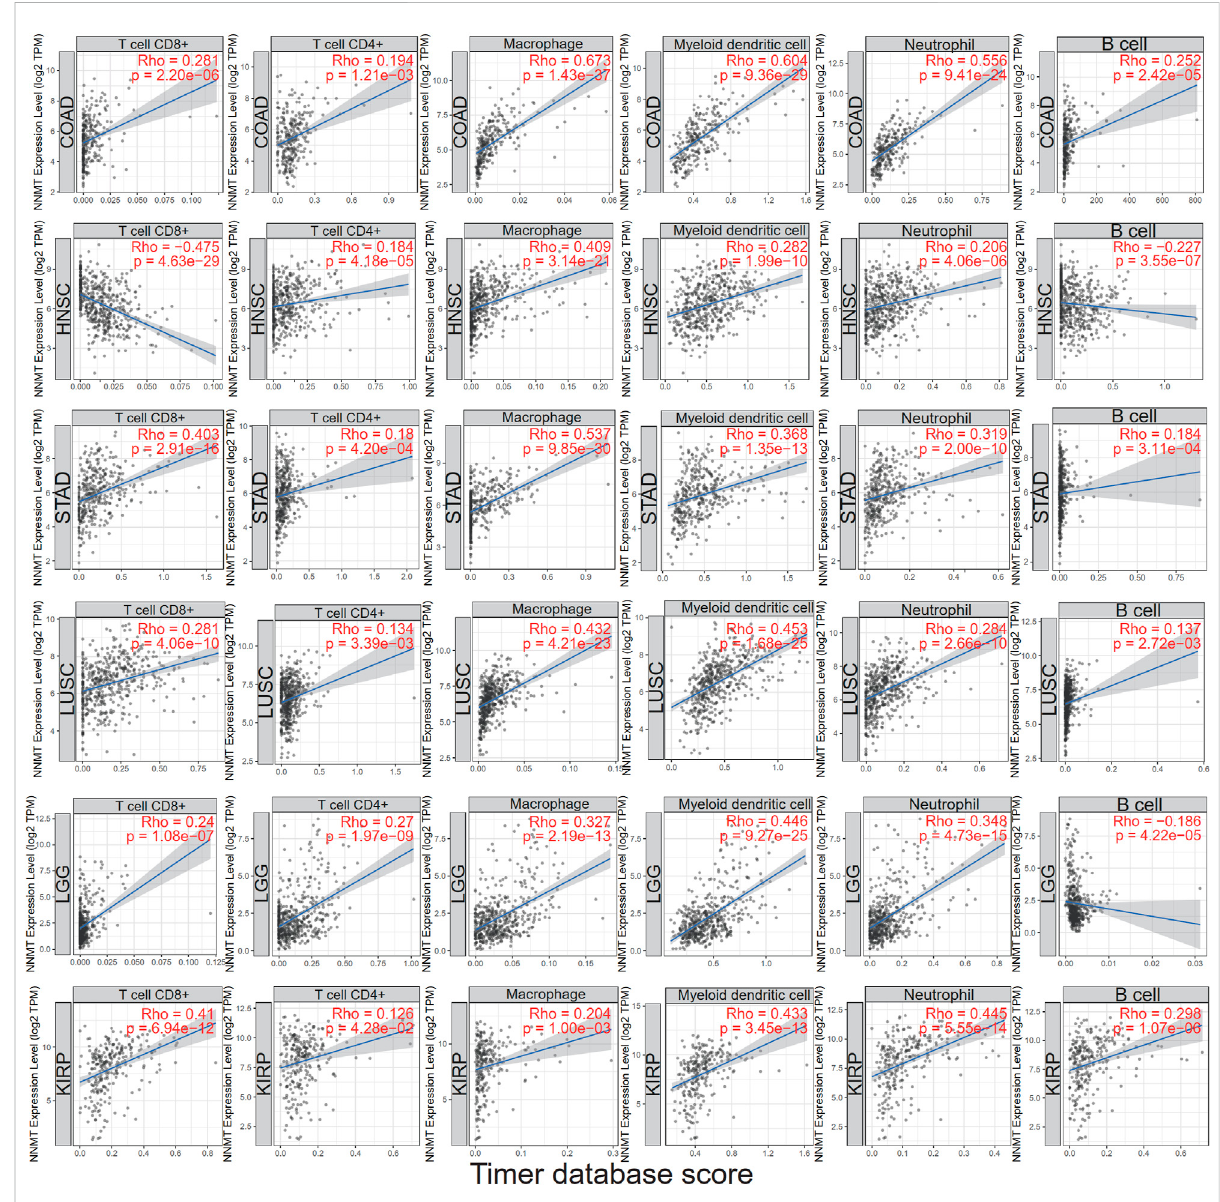
FIGURE 8 Using the in fi ltration scores of six immune cell types (CD8 + T cell, CD4 + T cell, macrophage, myeloid dendritic cell, neutrophil, and B cell) available in the TIMER2.0 database, a correlation was shown between NNMT expression and the degree of immune cell in fi ltration in different